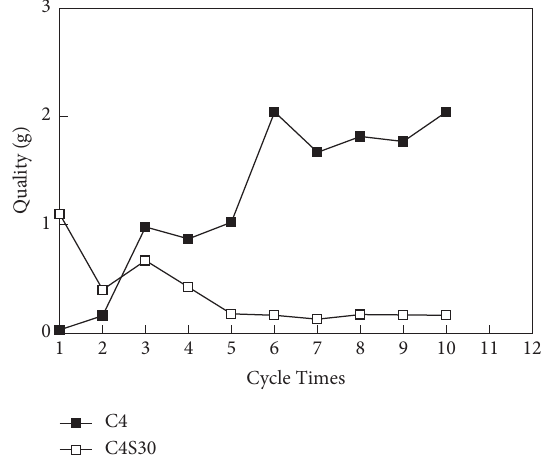
Figure 7: Change curve of quality loss of sample with the number of cycles.